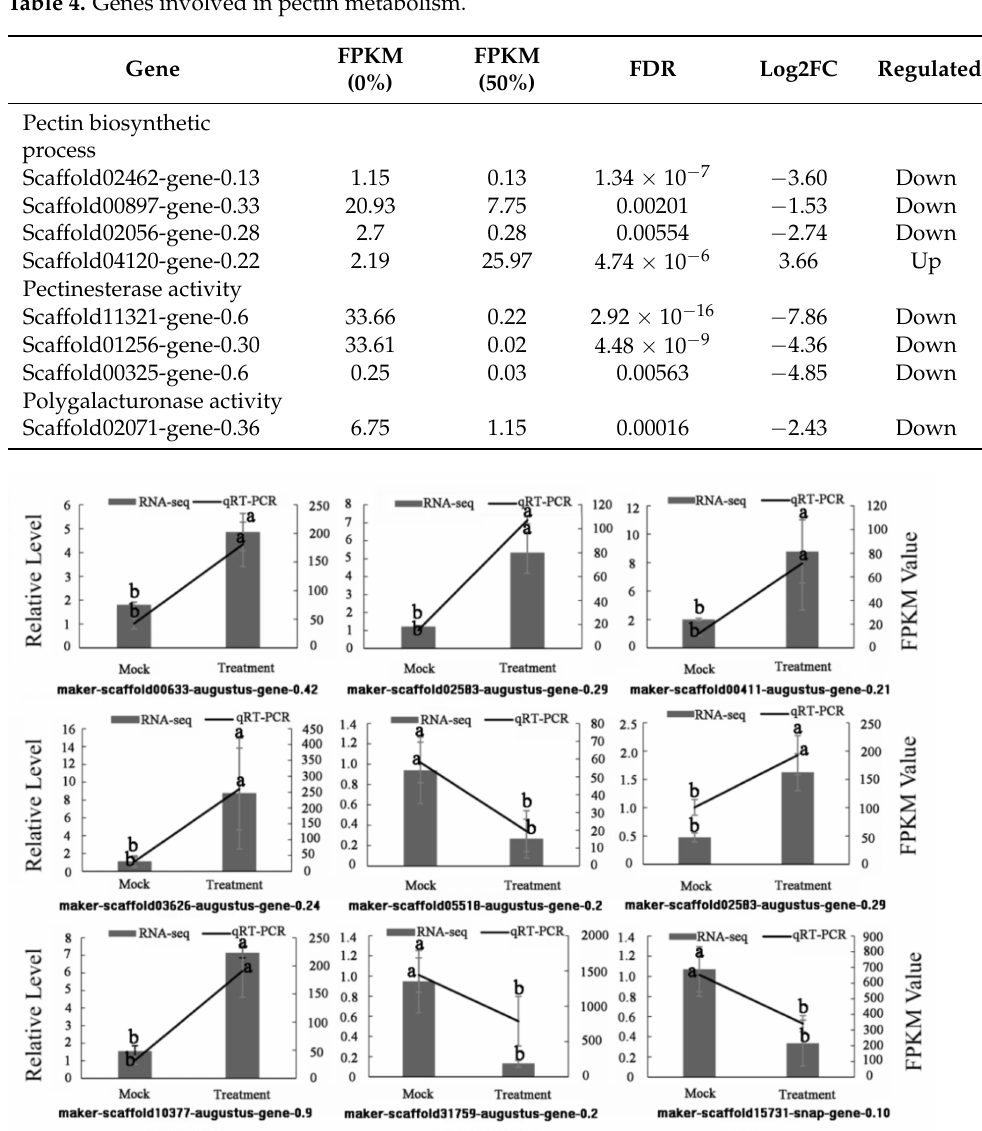
Figure 10. QRT-PCR validations of RNA-seq data. Relative expression was determined using three biological replicates. Black line: qRT-PCR expression, black bars: transcriptomics RNA-seq analysis (FPKM). The letters (a,b) indicate significant differences ( p <